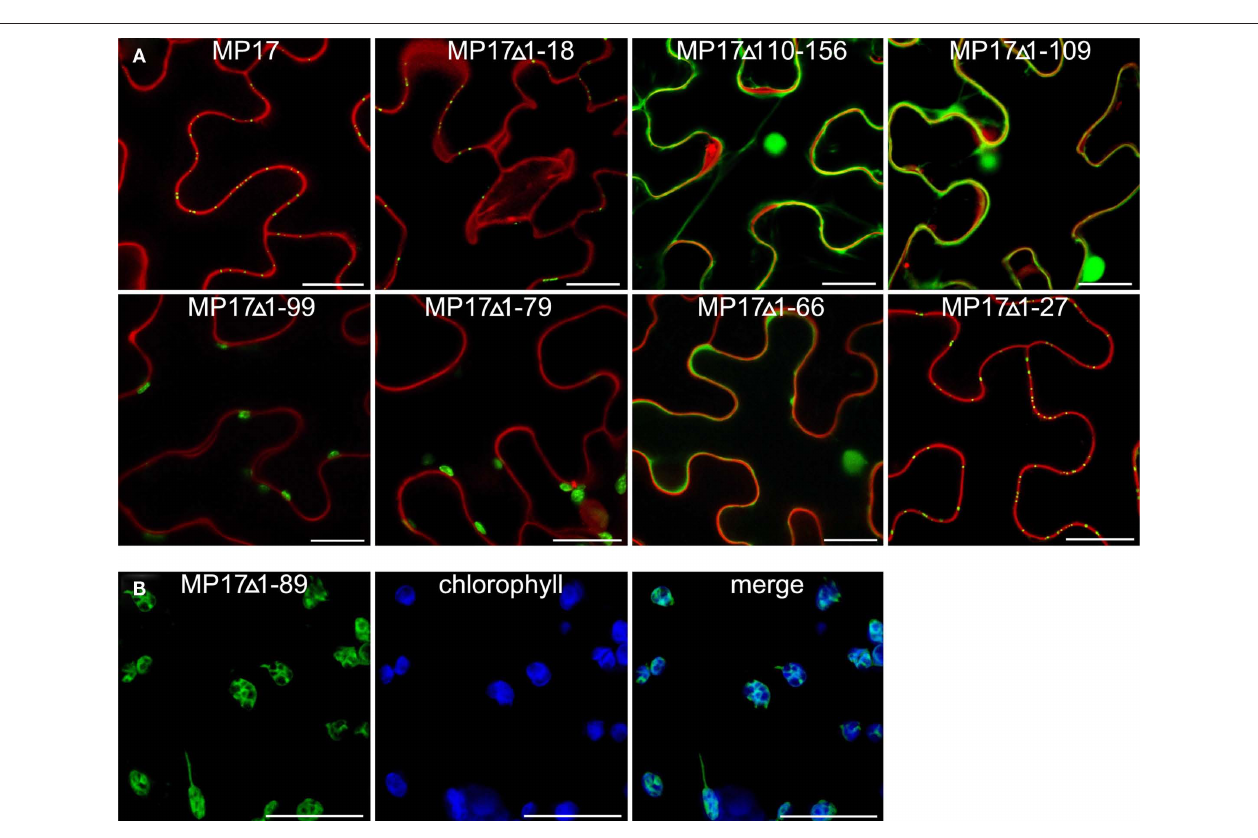
FiguRe 2 | intracellular localization of MP17 deletions. Confocal images of MP 17 deletion variants fused to C-terminal GFP after transient expression in N. benthamiana ; (A) superimpositions of MP17:GFP fluorescence in green with propidium iodide stained cell walls/nuclei in red in epidermal cells; (B) single images and merge (right) of green MP17:GFP fluorescence and blue chlorophyll auto fluorescence in mesophyll cells; bars represents 20